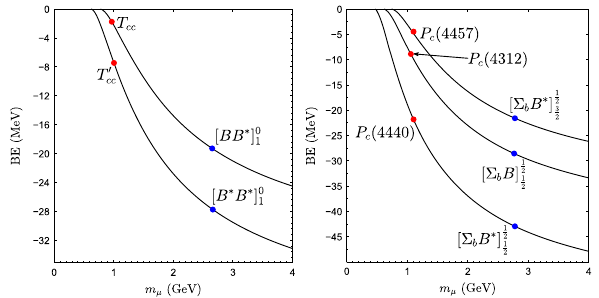
Fig. 1 The variation of binding energies for the T + cc , T (cid:3)+ cc , P c ( 4312 ) , P c ( 4440 ) , and P c ( 4457 ) states as their reduced masses increase. At m Q = m b , we have their bottom partners T − / 2 ∗ ] 1 / 2 [ (cid:3) , and [ (cid:3) b B ∗ ] 1 , b B 1 / 2 3 / 2